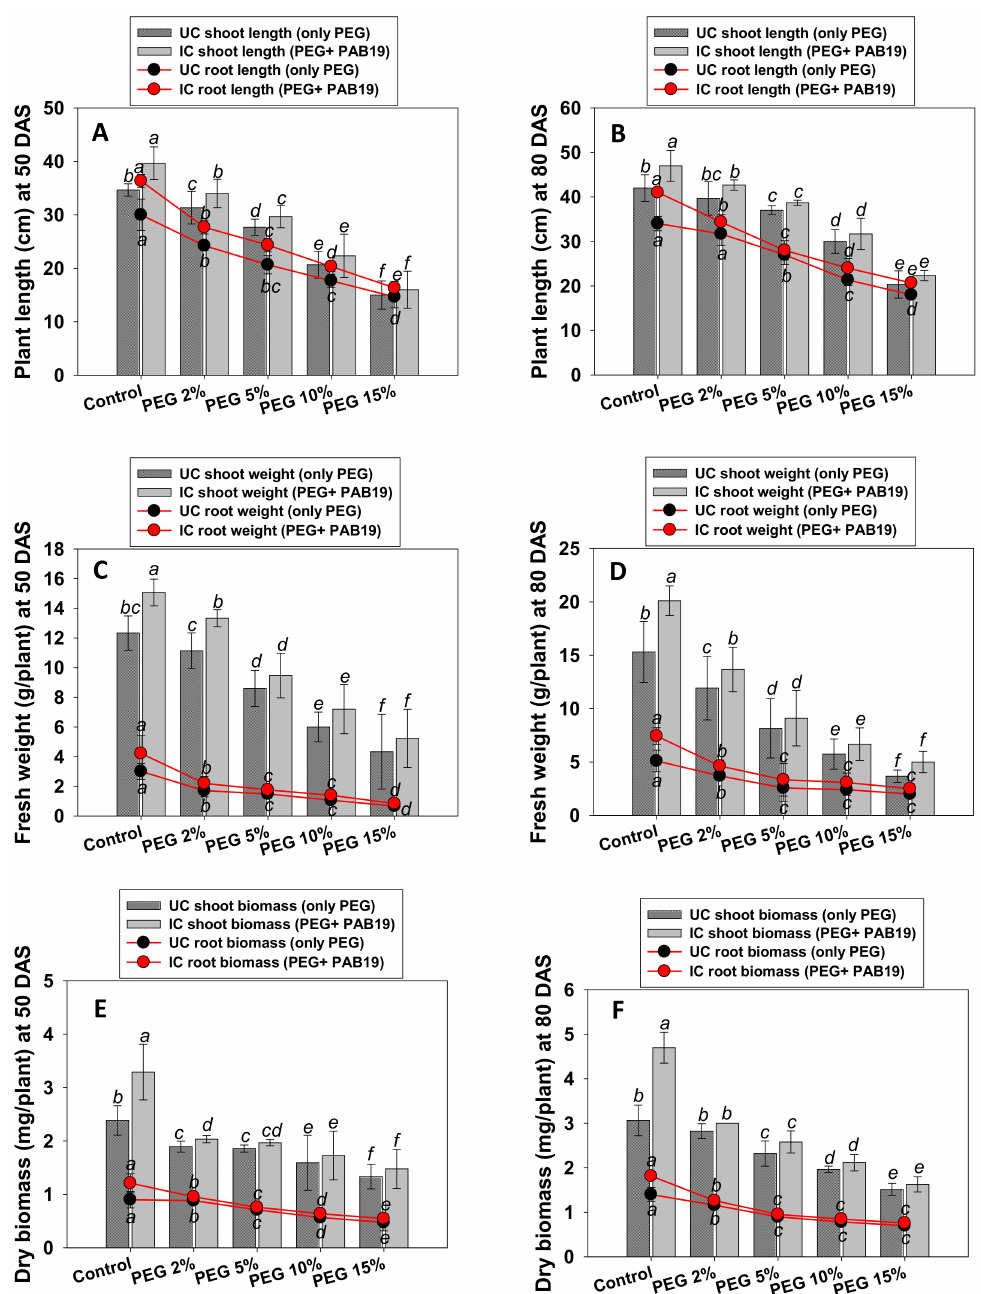
Figure 4. Impact of the bio-inoculation of Enterobacter sp./ L. adecarboxylata PAB19 on biological features; plant length at 50 DAS ( A ) and 80 DAS ( B ), fresh weight at 50 DAS ( C ) and 80 DAS ( D ), dry biomass at 50 DAS ( E ) and 80 DAS ( F ) of V. radiata (L.) cultivated under different levels of water stress (2%, 5%, 10% and 15% PEG-6000) under greenhouse conditions. Bar diagrams represent the mean values of three replicates. Mean values followed by different letters are significantly different ( p ≤ 0.05) as determined by the DMRT. Bar and scatter plots represent means ±